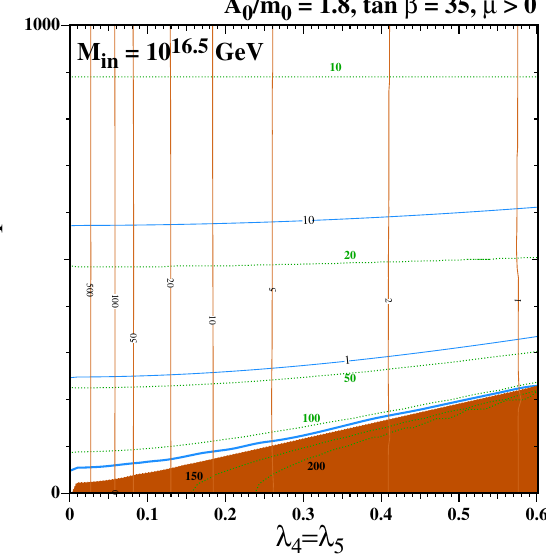
Fig. 9 Some ( M X 1 , m 1 ) planes in the FSU(5) GUT model with M 5 = 2 . 4 TeV, m 10 = 1 TeV, tan β = 35, A 0 / m 10 = 1 . 8. We assume m ¯ = m / 2 in the right panel. The contours are as in Fig. 1 in the left panel and m ¯ 10 5